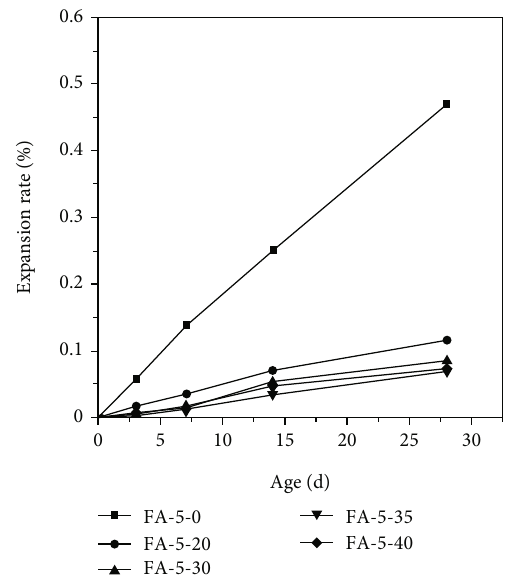
Figure 13: Graph of the expansion rate of the specimen and the amount of coal ash content (cement alkali content 2.00%).